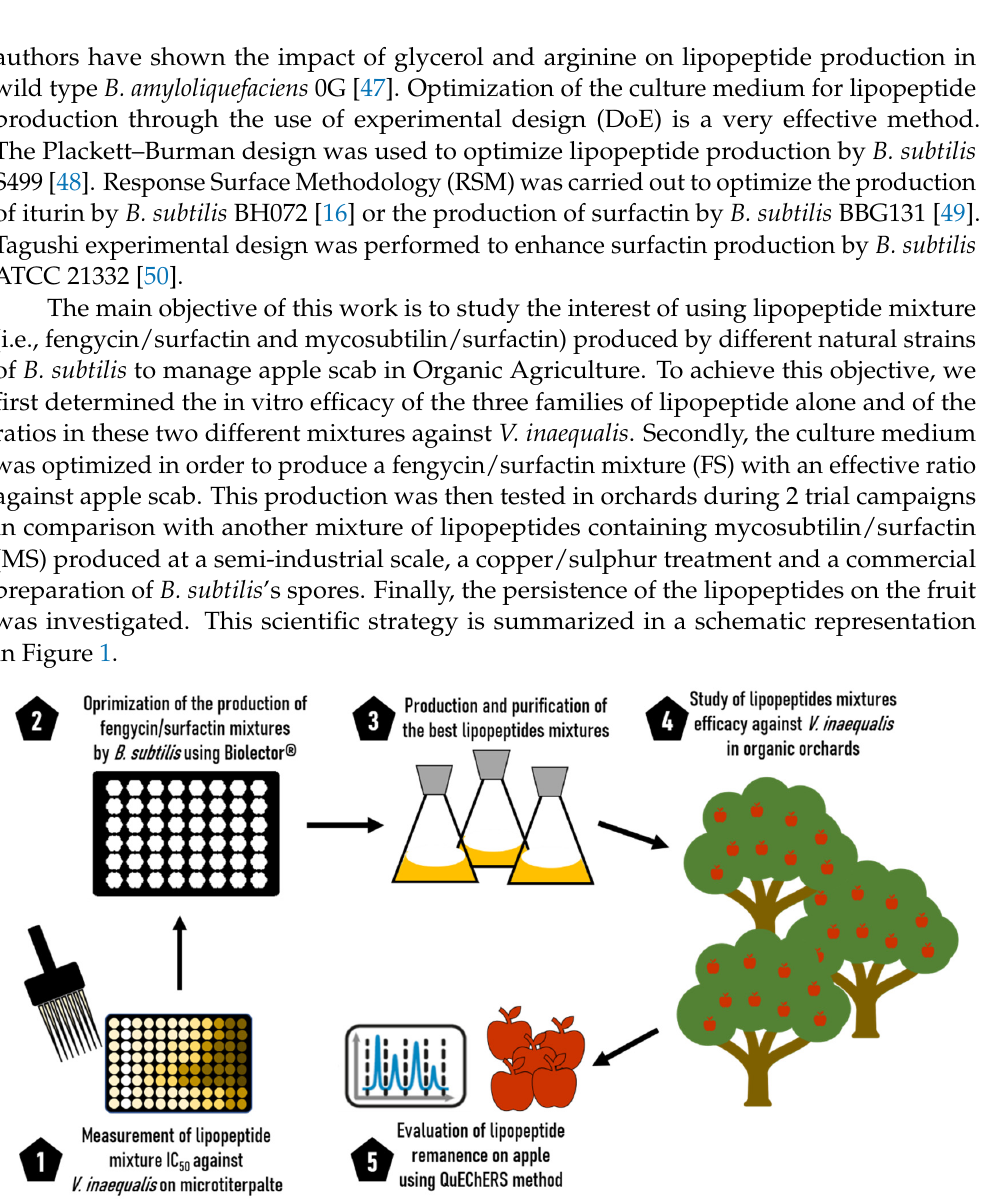
Figure 1. Schematic representation of scientific strategy developed in this work. Step 1: in vitro screening of the best lipopeptide mixture against V. inaequalis ; Step 2: Optimization of the lipopeptide mixture production; Step 3: Production and purification of the different mixtures of lipopeptides in shacked flask; Step 4: Study of lipopeptide mixture efficiency against V. inaequalis in organic orchards; Step 5: Lipopeptide remanence evaluation using QuEChERS